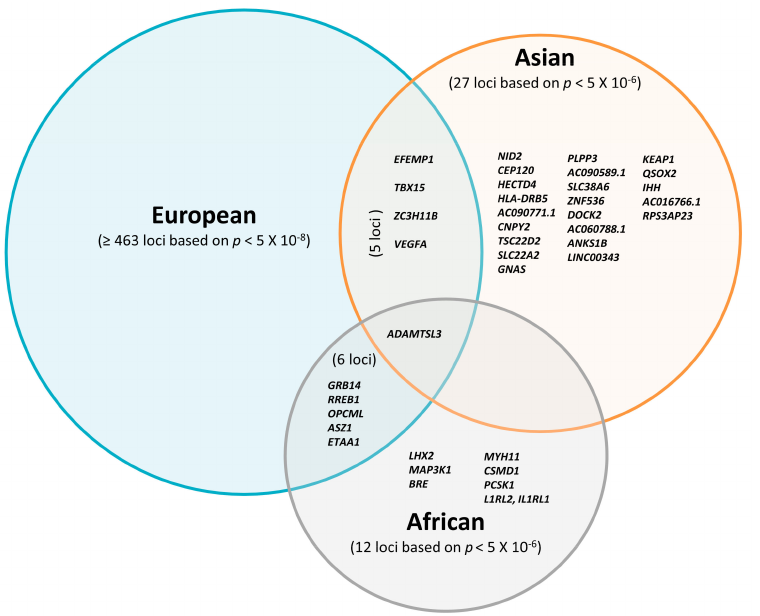
Figure 1. Overlap of reported loci associated with fat distribution traits in Europeans based on p < 10 − 8 ; Asians and Africans are based on p < 10 − 6